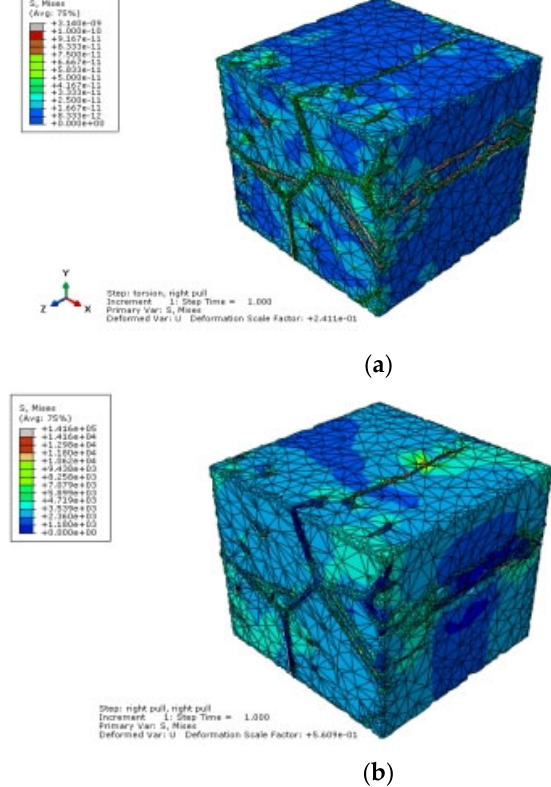
Figure 23. ( a ) The micro model: embedded in tension; ( b ) embedded in torsion.